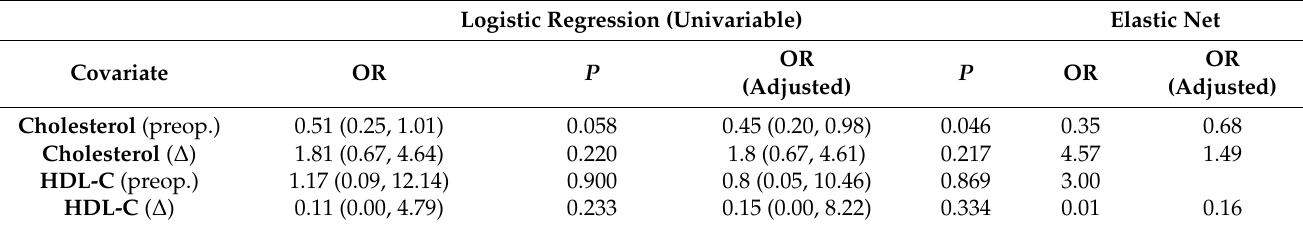
Table 5. Association between individual lipids (in units (mmol/L)) and the outcome survival after one year follow-up. Preoperative values as well as their change during the operation (postoperative minus preoperative) are presented. The left part of the table shows odds ratios (OR) and their 95% confidence intervals for the case of univariable regressions both for the crude association and adjusted for the confounders age, sex, BMI, and statins. The right part shows the OR computed by an elastic net logistic regression to account for the correlation across the lipids. An OR > 1 refers to increased risk, and OR < 1 refers to a protective effect with respect to a unit change in a particular